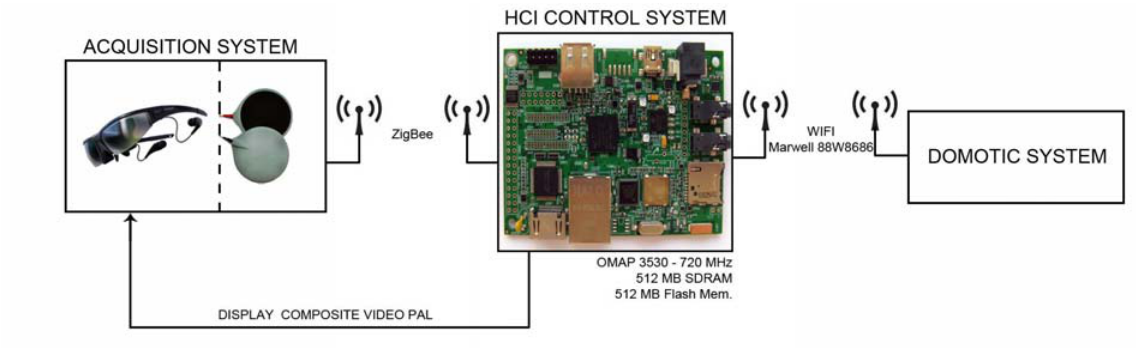
Figure 1. System architecture.